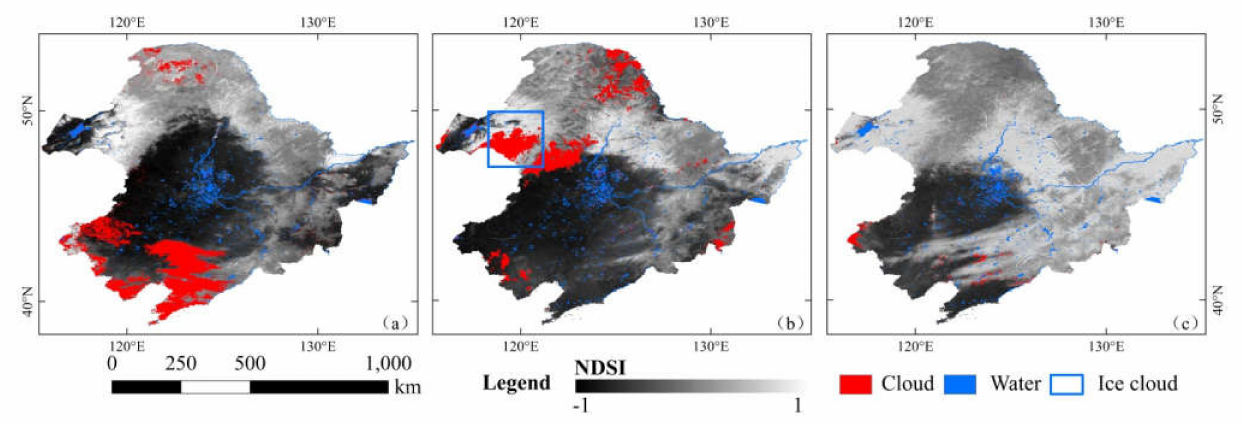
Figure 11. New NDSI_Snow_Cover layer. ( a ) 12 February 2019, ( b ) 22 March 2018, and ( c ) 16 March